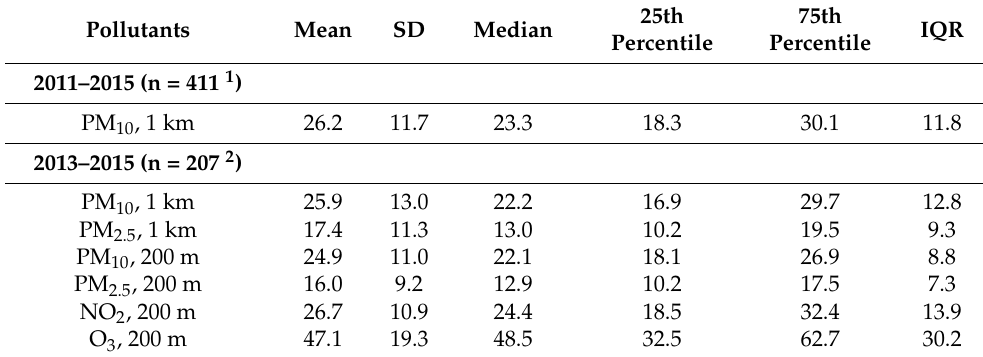
Table 2. Mean, SD, median, 25th and 75th percentile, and interquartile range (IQR) of the estimated pollutant levels ( µ g/m 3 ) throughout all the study days, for the whole period (2011–2015) and for the sub-period (2013–2015).